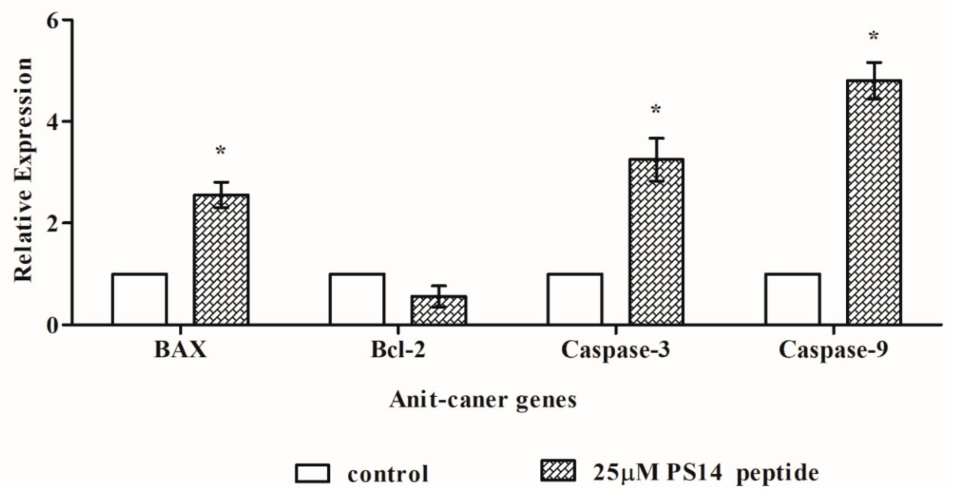
Figure 7. qPCR analysis of apoptotic gene expression due to PS14. The data were normalized with the internal control molecule, GAPDH. Results were compared with the untreated control and presented the data as fold change. The data were presented as mean ± SD of three replicates. The asterix (*) represents the significant difference at p < 0.05 compared to the